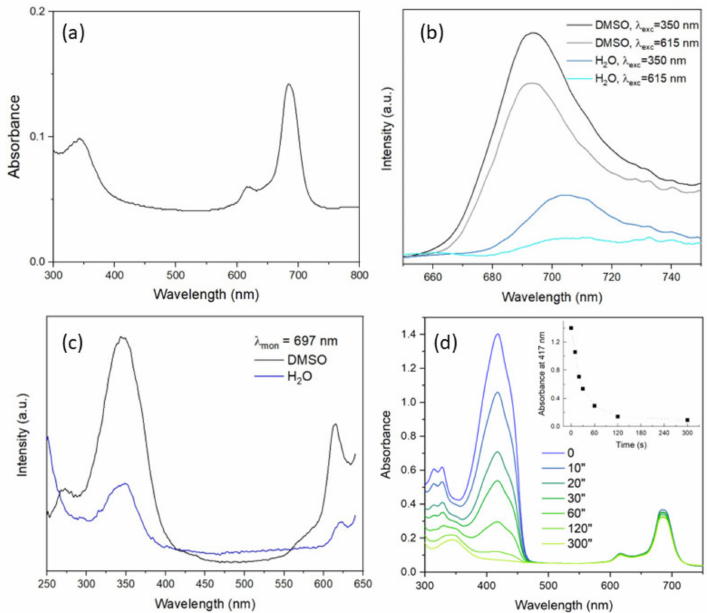
Figure 4. ( a ) Absorption spectrum of glass (BGl@PcHfCl 2 ) in DMSO suspension. ( b ) Photolumines- cence spectra of glass in DMSO and water under UV and red-light excitation. ( c ) Photoluminescence excitation spectra of glass in DMSO and water. ( d ) Absorption spectra of glass in DMSO in presence of diphenylisobenzofuran after different time of red-light irradiation (inset shows time-dependent decay of absorption band of DPBF monitored at 417